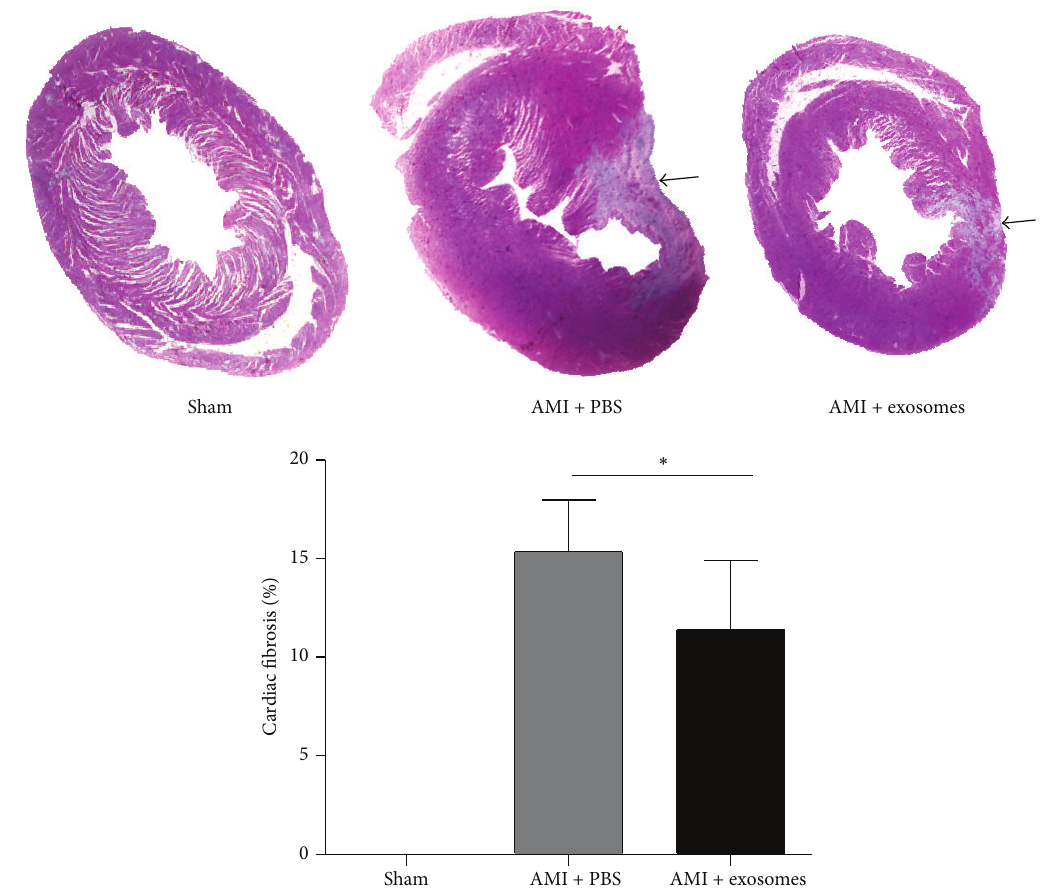
Figure 5: hucMSC-exosomes reduced cardiac fibrosis. Representative micrographs of sections of the left ventricles stained with Masson’s trichrome and the percentage of cardiac fibrosis. Arrows indicate the fibrotic myocardial tissue. ∗ 𝑃 < 0.05 versus AMI + PBS.